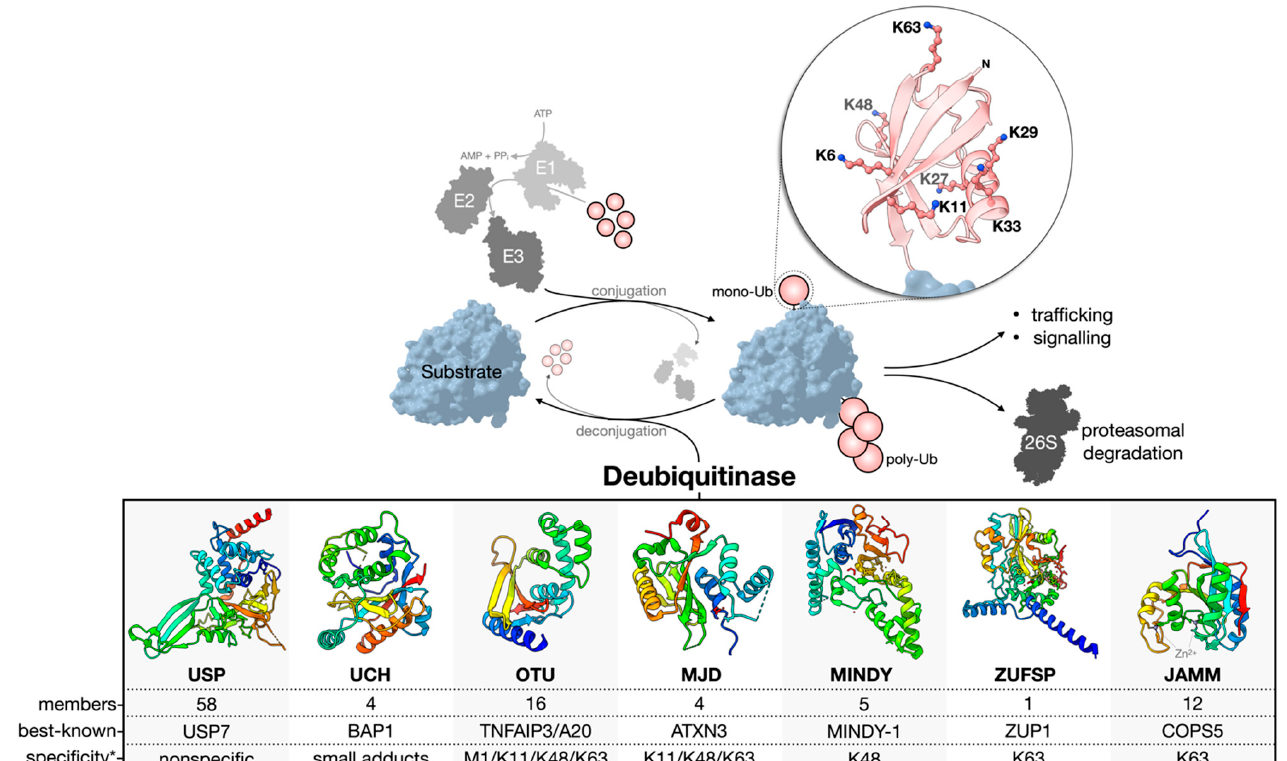
Figure 1. Ub conjugation and deconjugation. Ubiquitination is an ATP-dependent process orches- trated by an E1–E2–E3 enzymatic cascade utilizing free, mono-Ub. The N-terminus or any of the seven lysine residues of Ub can be ubiquitinated to facilitate poly-Ub chain assembly following the sequential rounds of conjugation. The removal or deconjugation of Ub is then mediated by DUBs, for which seven families have been classified. The structure of the DUB catalytic domain of a repre- sentative family member is shown: USP, USP7 pdb 4m5w [48]; UCH, UCH-L3 pdb 1uch [49]; OTU, OTUD1 pdb 4bop [25]; MJD, Jos-2 pdb 6pgv [50]; MINDY, MINDY-1 pdb 5jqs [41]; ZUFSP, ZUP1 pdb 6ei1 [51]; JAMM, STAMBPL1 pdb 7l97 [52]. The most well-known member of each family is presented based on the number of publications curated from the NCBI Entrez database. * The reader should be aware that reported Ub chain specificities are assay-dependent, and many exceptions